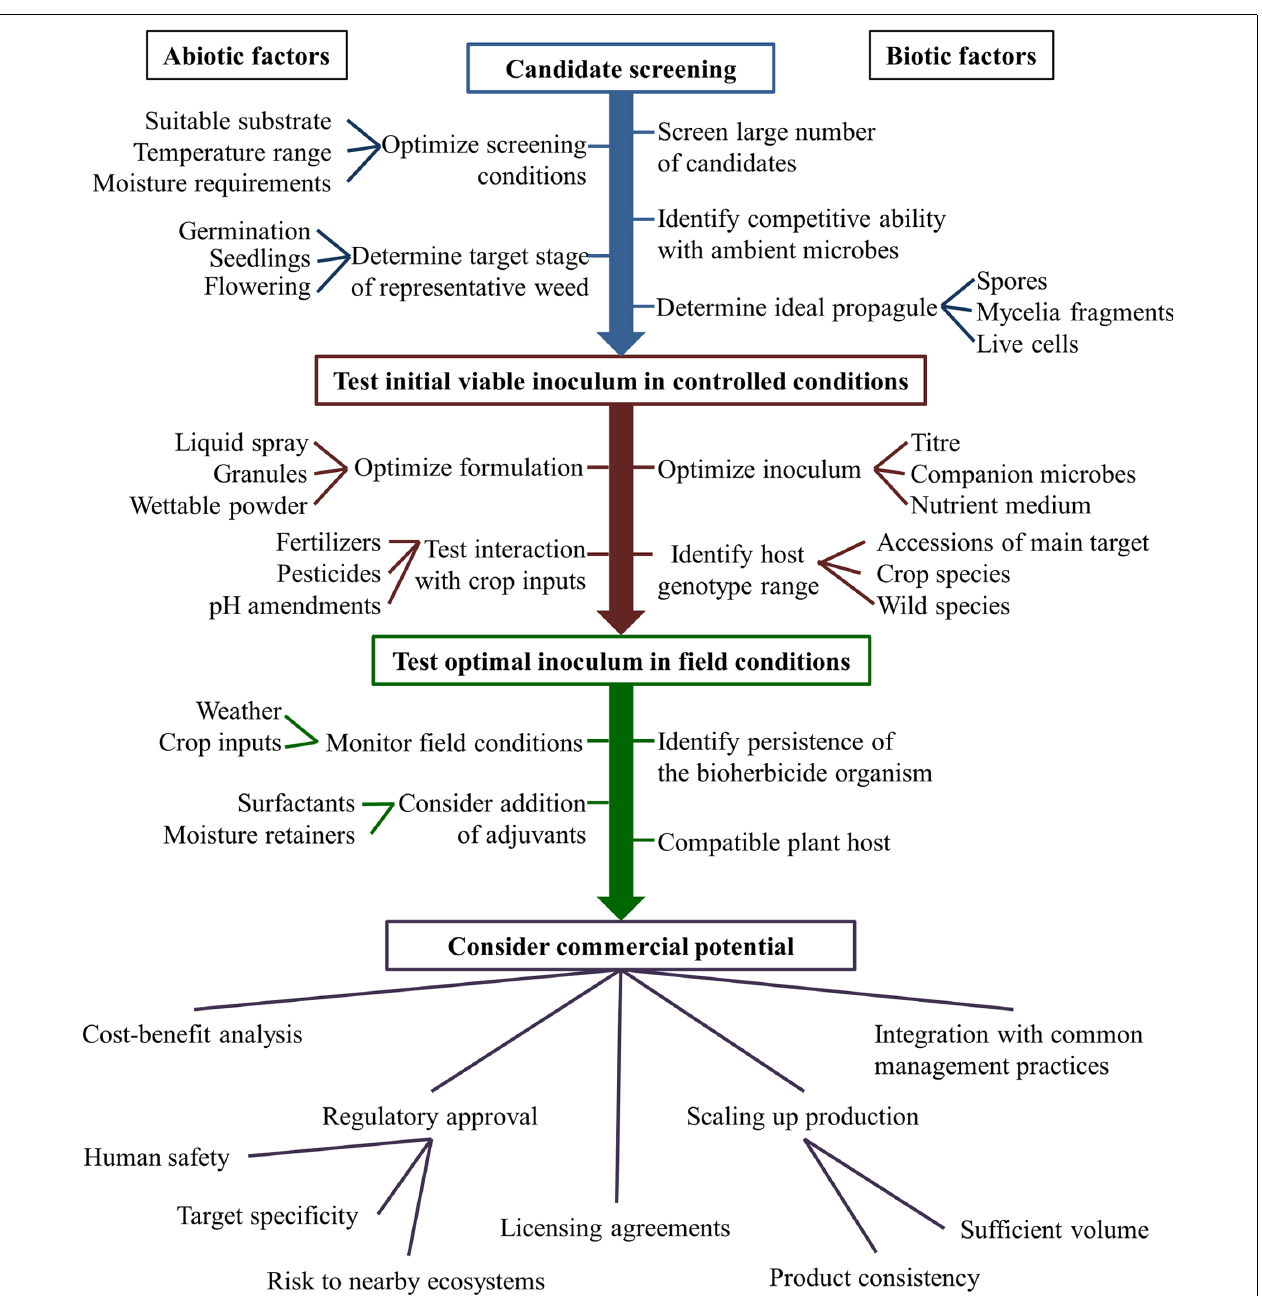
FIGURE 1 | Overview of factors involved in the development of a